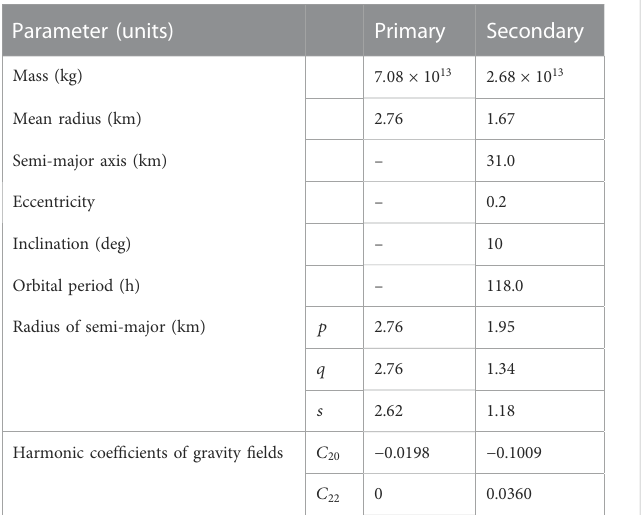
TABLE 1 Parameters of the binary asteroid system 4951 Iwamoto.